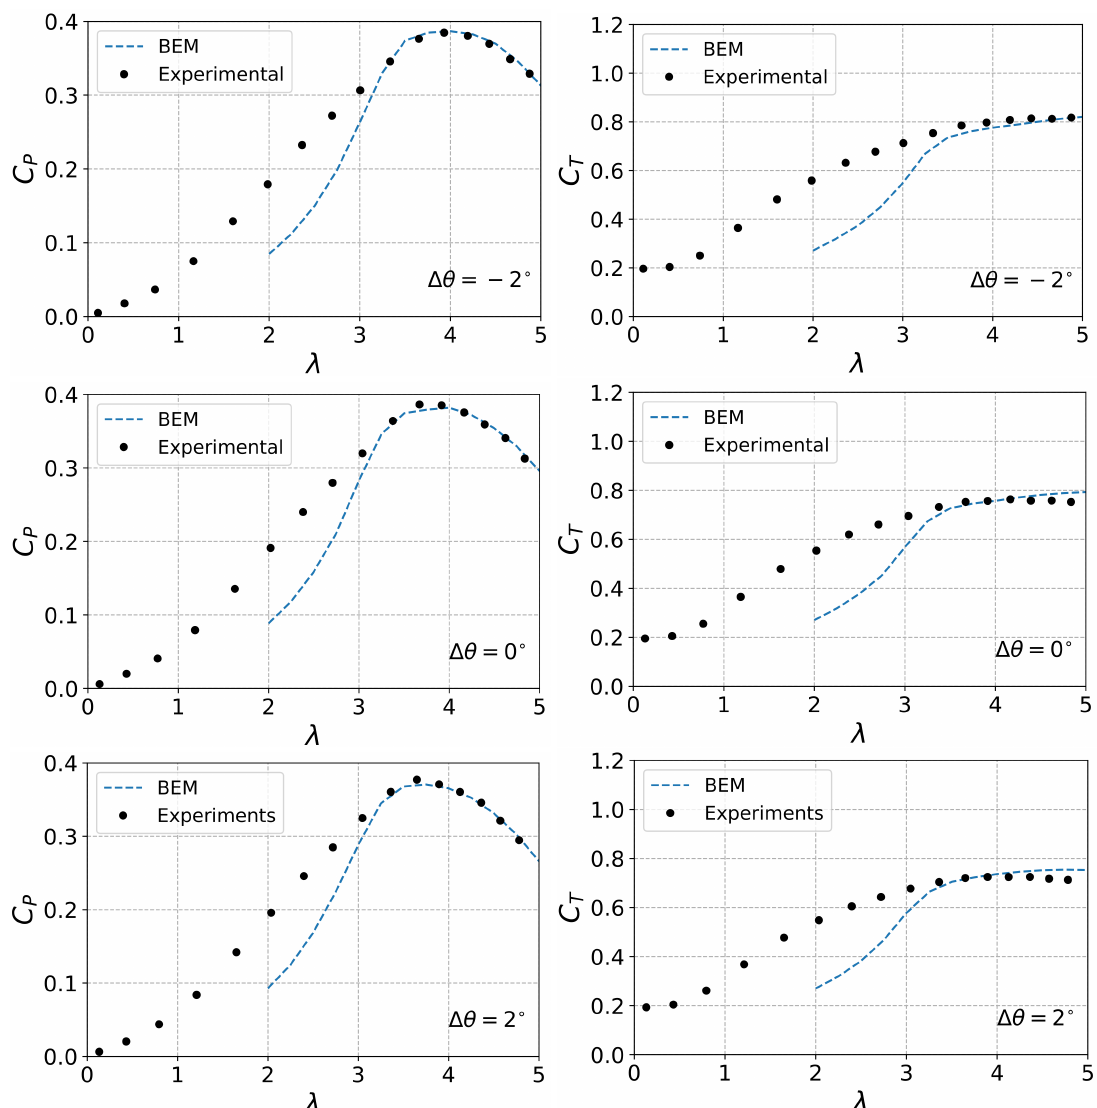
Figure 9. Comparison between experimental and BEM results for variable unbalanced pitch.